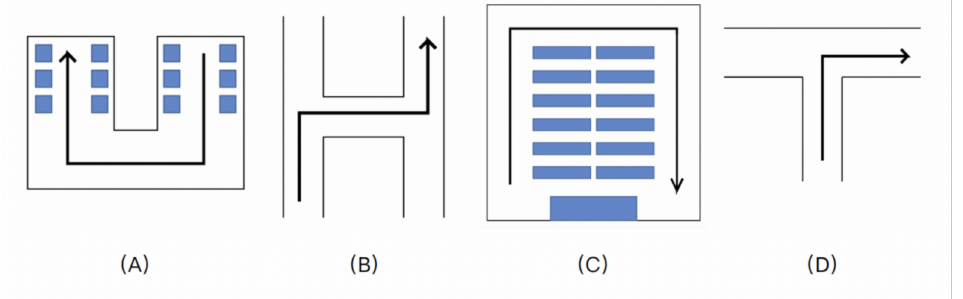
Figure 5. The experimental scenes. ( A ) U-shaped hallway; ( B ) H-shaped hallway; ( C ) Loop-shaped hallway; and ( D ) T-shaped hallway.